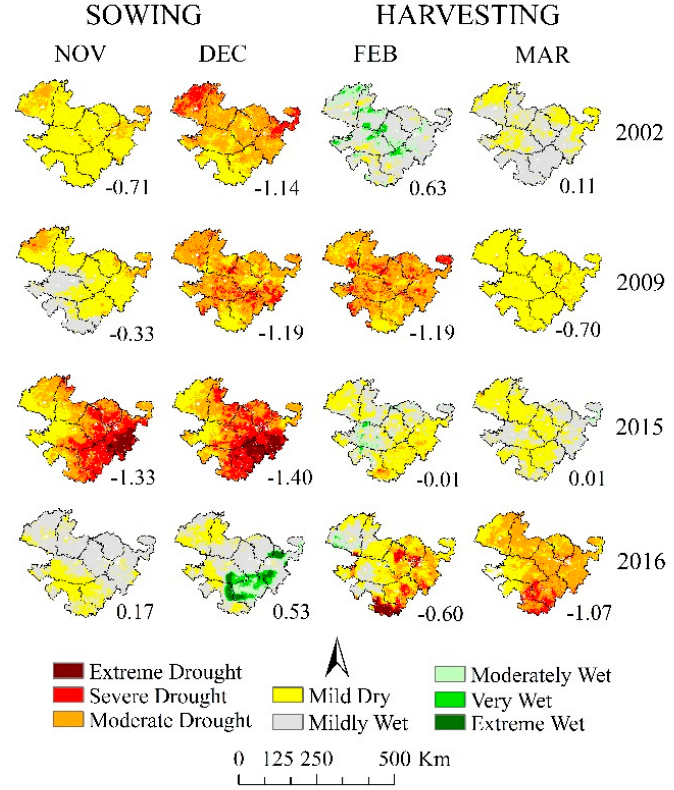
Figure 12. Spatio-temporal representation of CDI_M values over the Rabi season in the Marathwada (bottom right value indicate the monthly average CDI_M over the study area).